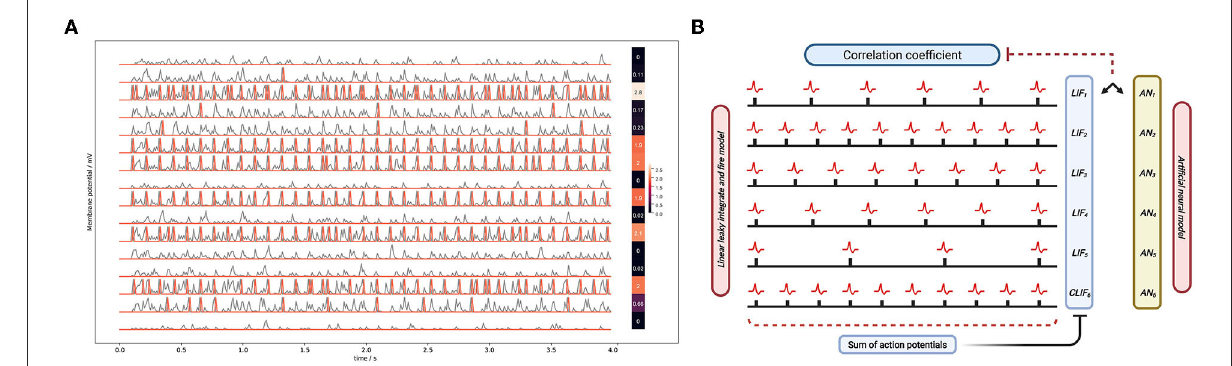
FIGURE11 (A) The membrane potential of LIF neurons. The left curve shows the state of 16 LIF neurons. The first heat map on the right shows the number of spikes of LIF neurons as arranged in a map. Each data corresponds to the LIF membrane potential data on the left. The other heat map is the same but for the ReLU neurons. (B) The framework of calculating the correlation coefficient.